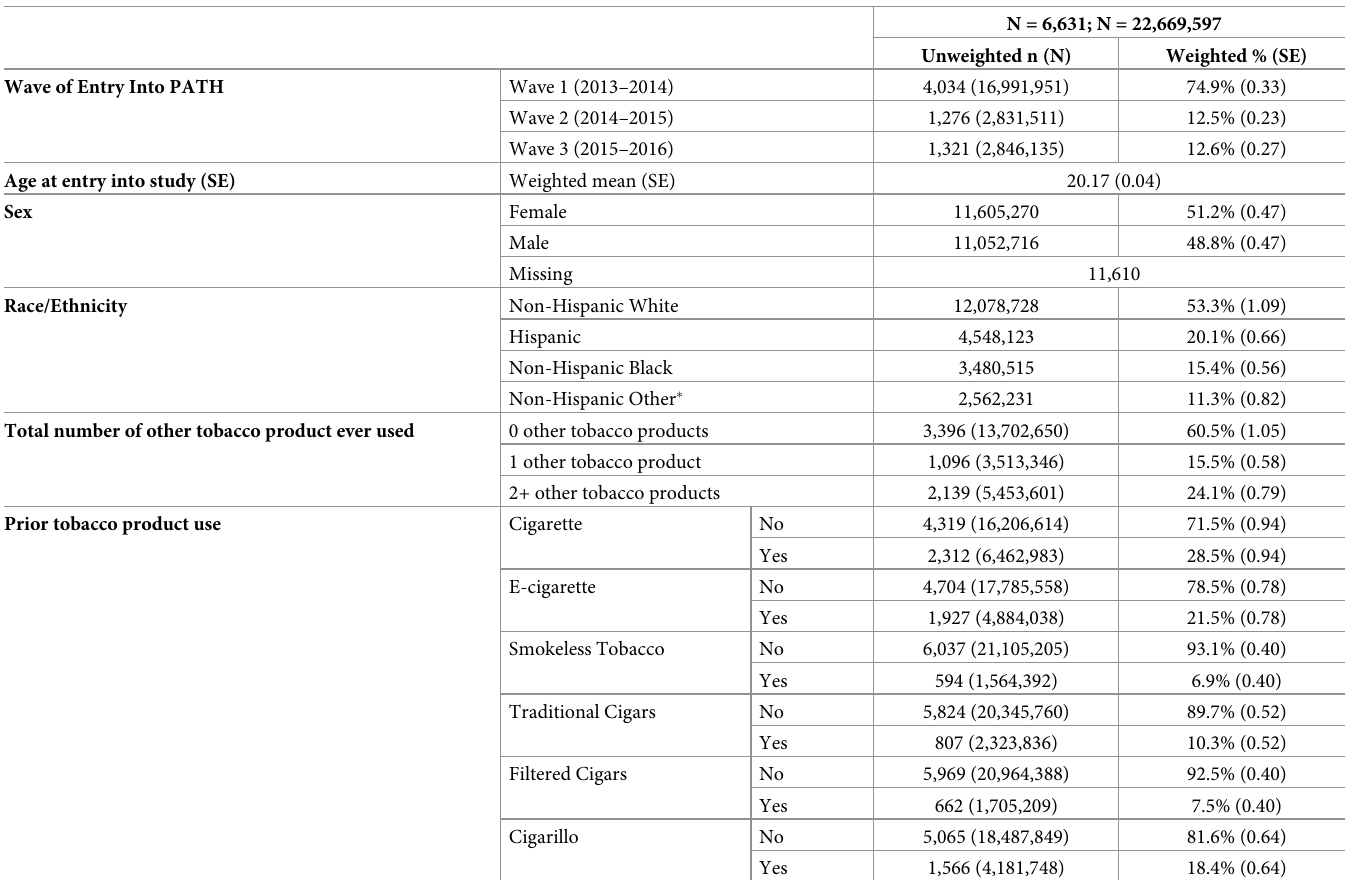
Table 1. Demographic characteristics of PATH¥ USA young adult (aged 18–24) never hookah users at their first wave of adult participation (2013–2016).